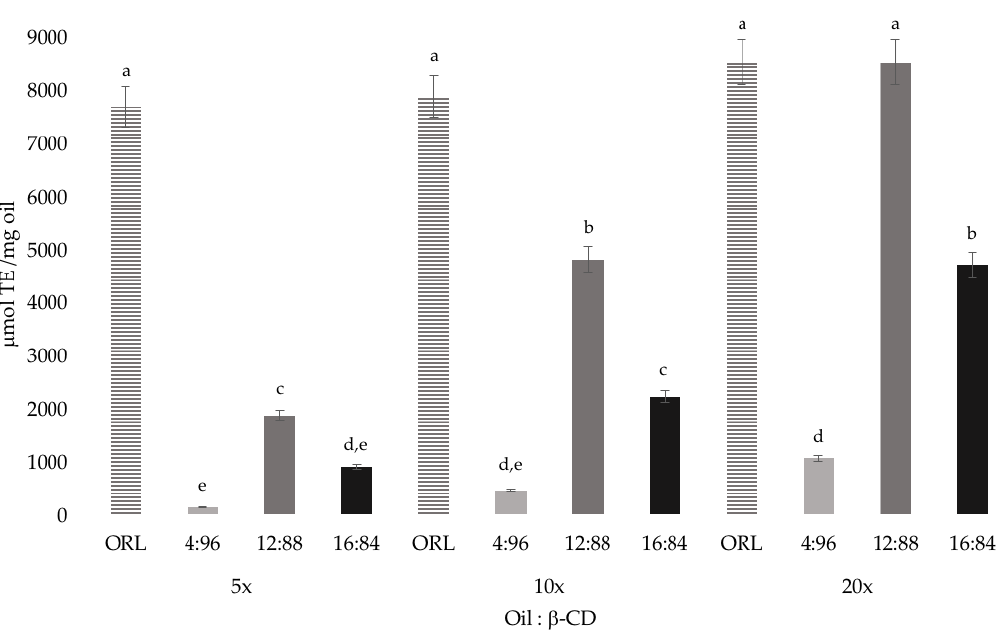
Figure 4. Antioxidant activity of the inclusion complexes of concentrated orange oils with β–CD in different ratios. Data were analyzed by an analysis of variance test (one-way ANOVA) and a post hoc test of Tukey’s multiple range. Different letters (a, b, c, d, e) above bars are significantly different ( p < 0.05).